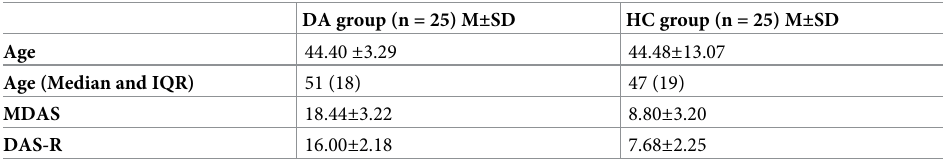
Table 1. Demographic and clinical characteristics of the